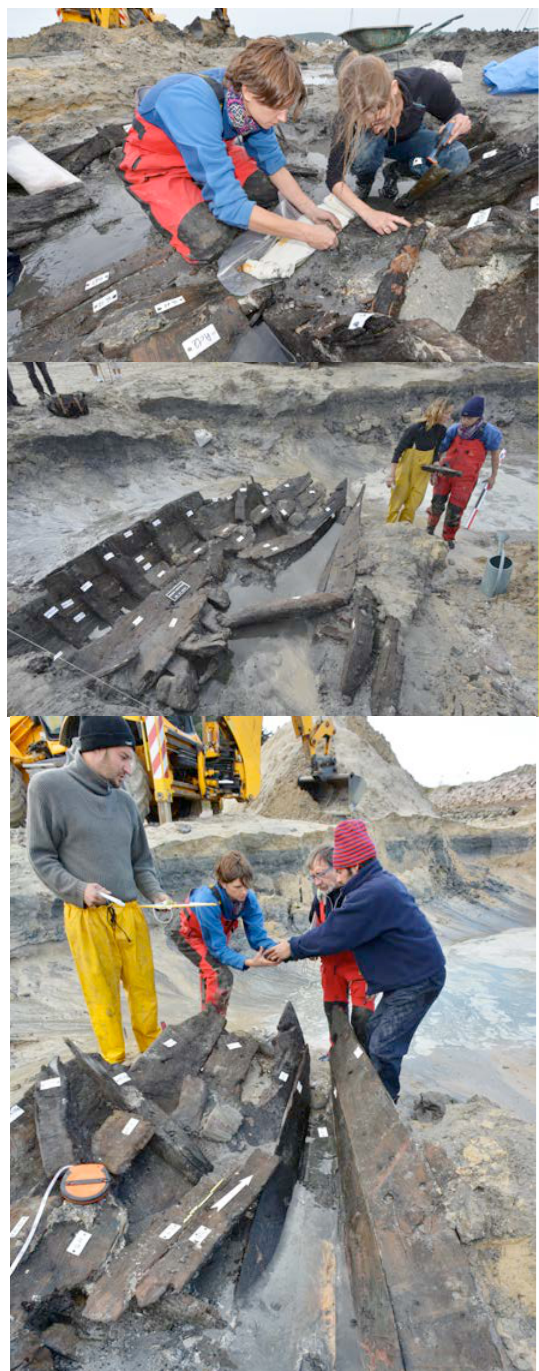
Figure 5. Excavation of the wreck